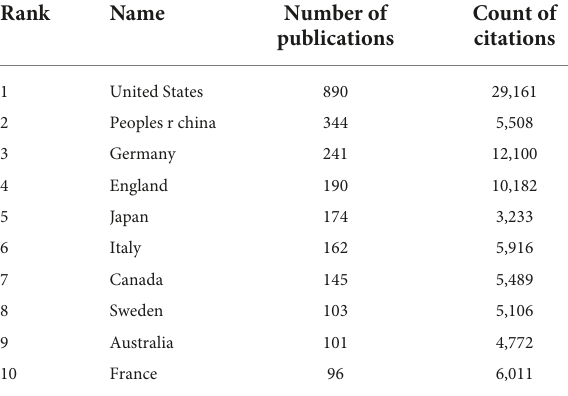
TABLE 3 The top 10 most active countries/regions related to PCa bone